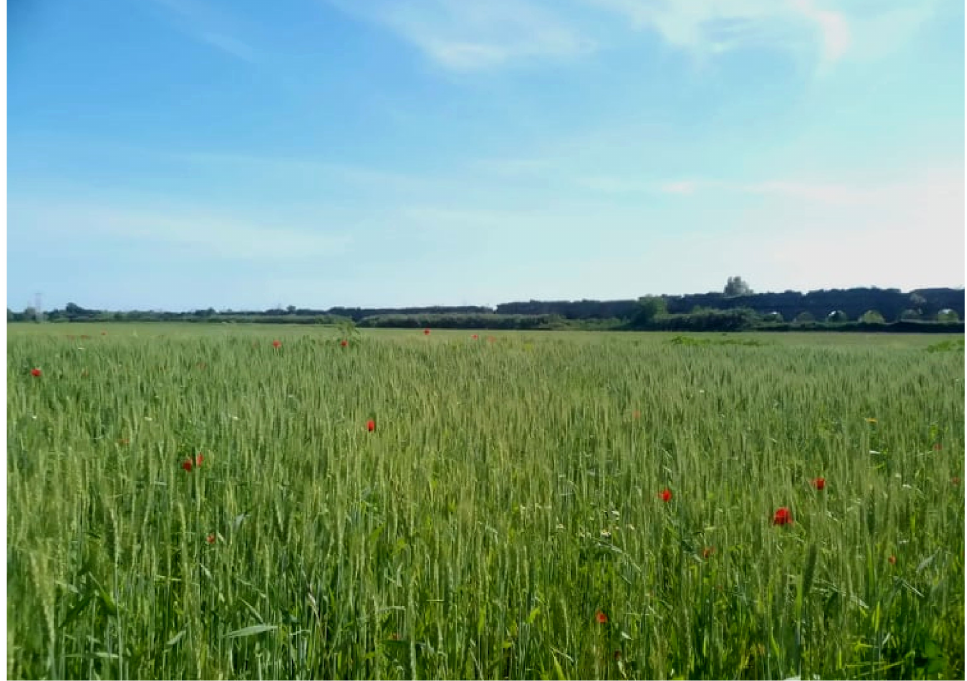
Figure 11. Landscape elements of Appia Antica Regional Park: matrix. Wheat field in locality